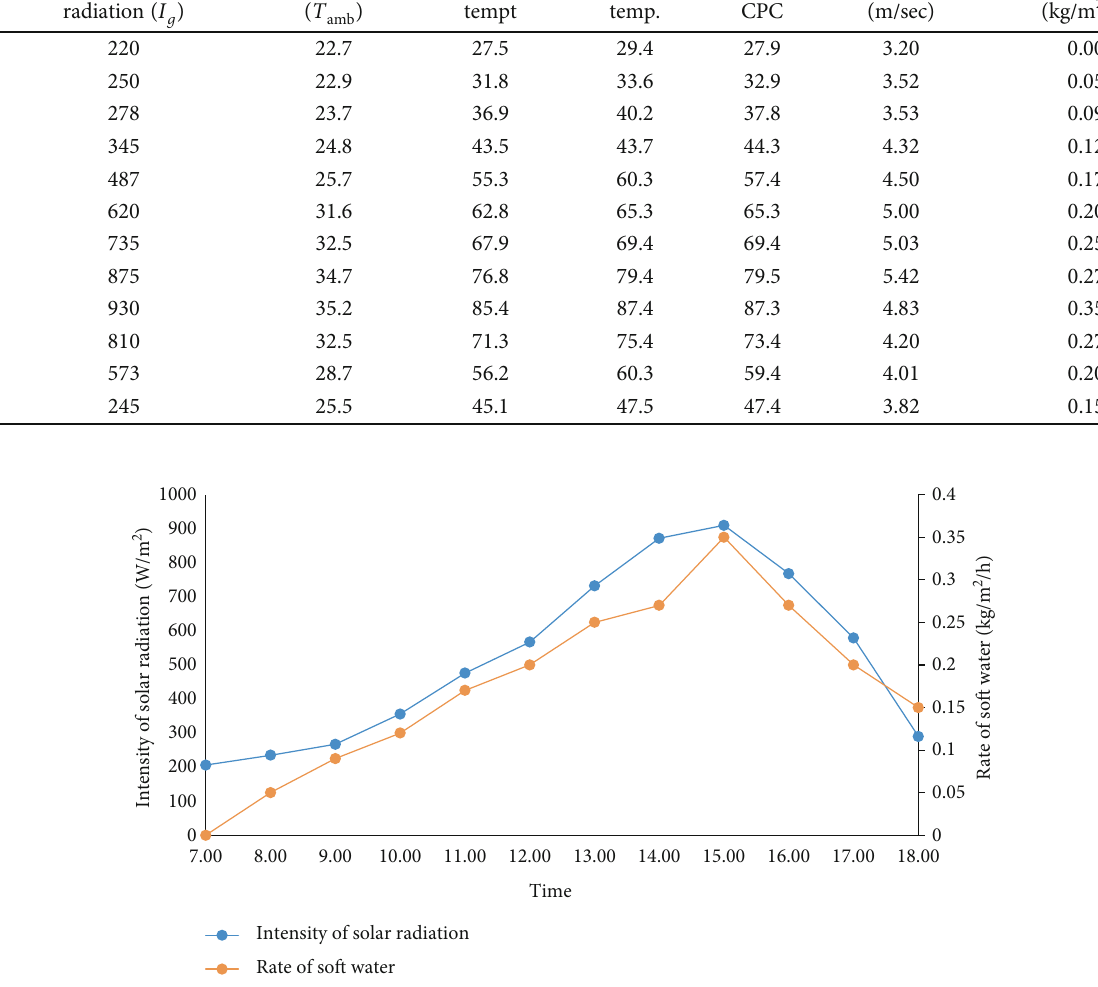
Table 4: Hourly variations of measured parameters in May 2018 with chrome mirror silver vinyl wrap material of CPC. Ambient temp. The intensity of solar Time ) radiation ( I g